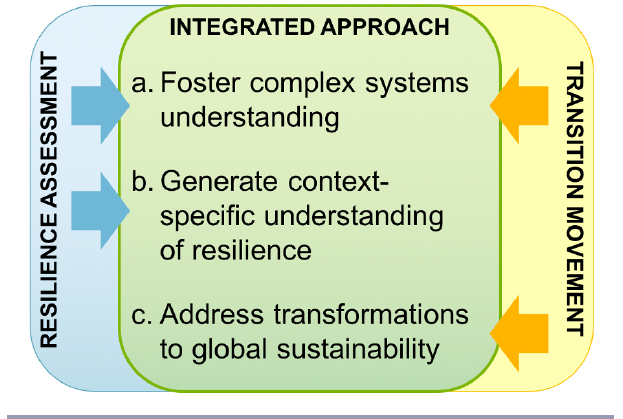
Fig. 4 . Integrating approaches to improve participatory resilience assessment. Illustrating how complementary